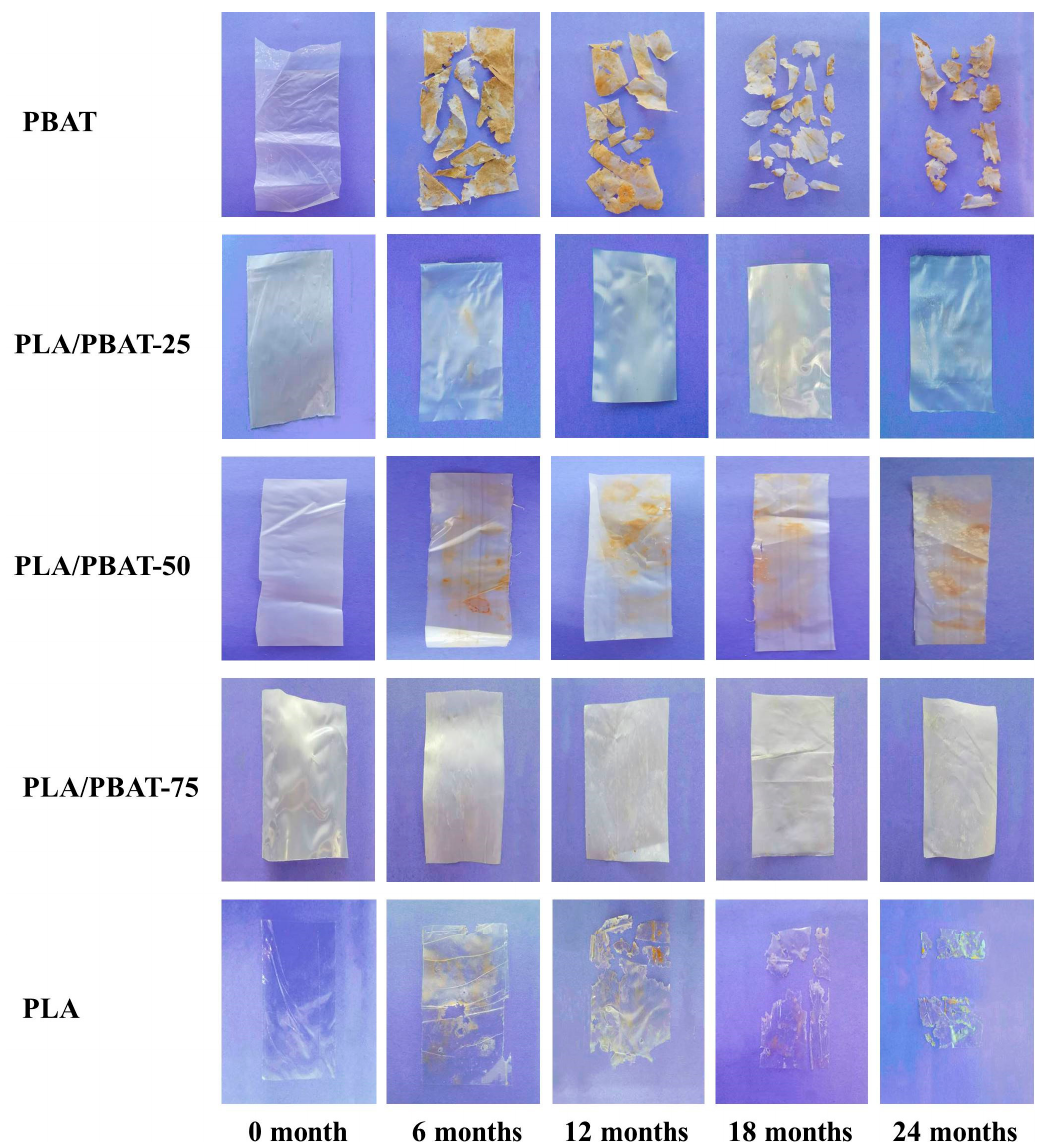
Figure 2. The appearance changes of PBAT, PLA and PLA/PBAT films with different incubation times in the freshwater sediment.